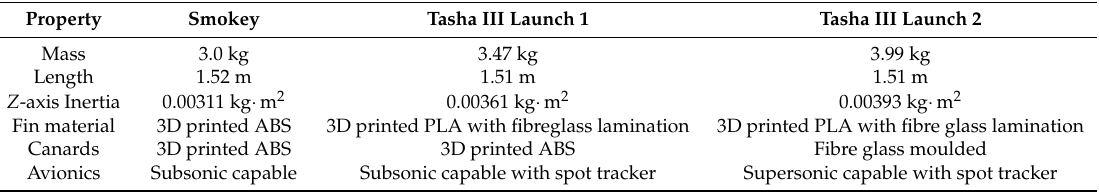
Table 1. Vehicle comparisons between Smokey and Tasha III.